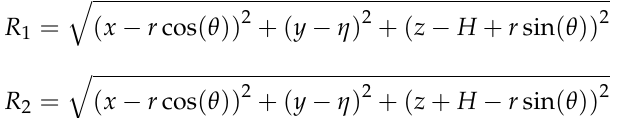
Figure 4. Free-field ground movements induced by different force patterns: ( a ) support pressure at tunnel face; ( b ) frictional force of shield shell; ( c ) torsional force of cutter head.